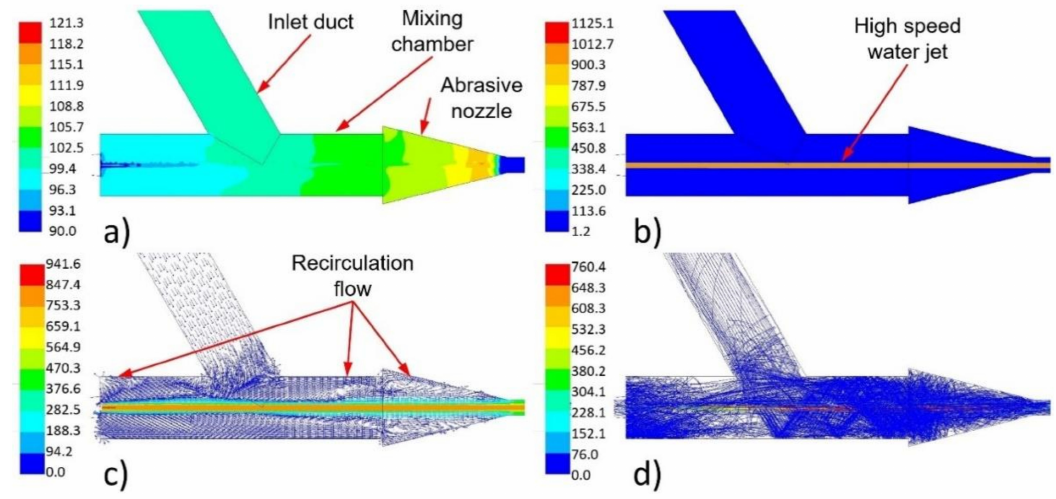
Figure 10. Calculated flow field in the mixing chamber and in the conical inlet part of the abrasive nozzle under the feeding pressure of 406 MPa: ( a ) distribution of the absolute pressure (kPa); ( b ) distribution of the density (kg/m 3 ); ( c ) distribution of the velocity vector (m/s); ( d ) abrasive particle traces coloured by particle velocity magnitude (m/s)—abrasive particle mass flow rate of 100